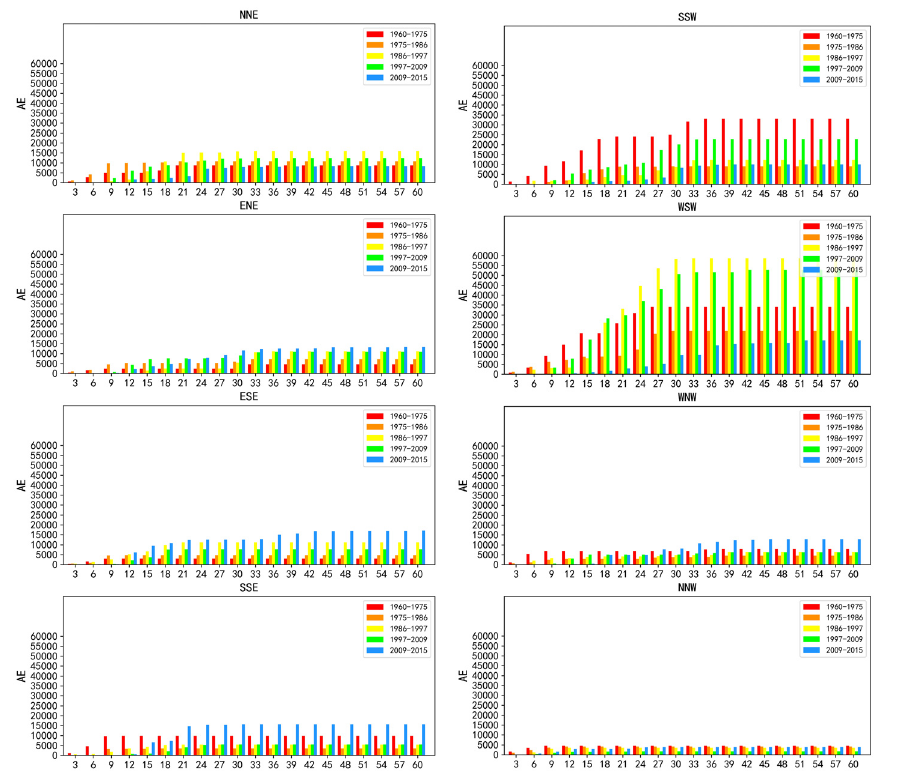
Figure 2. Annual expansion per direction across concentric rings during 1960–2015.